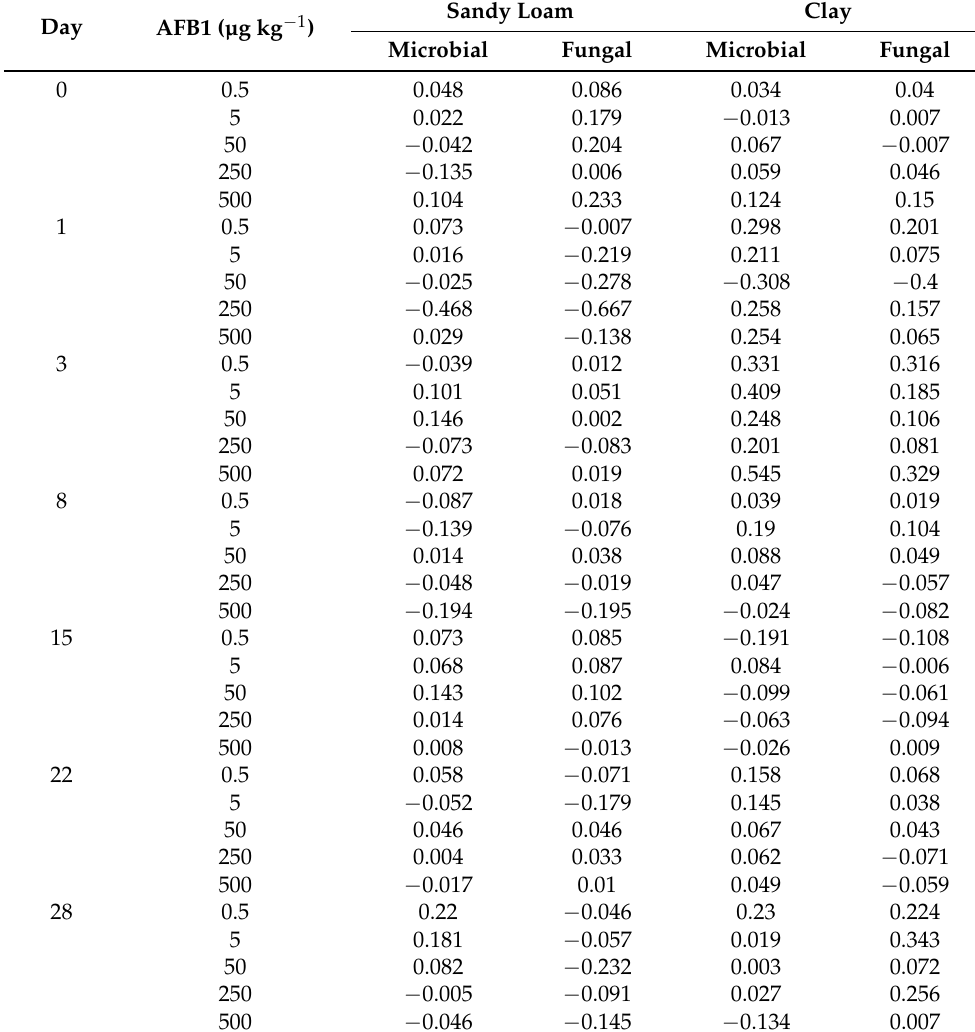
Table A1. Principal response curves: Differences in the canonical coefficients of the treatments (i.e., the individual AFB1 concentration levels) from the nonspiked control for both soils (sandy loam and clay) and systems (microbial and fungal) over 28 days of incubation.